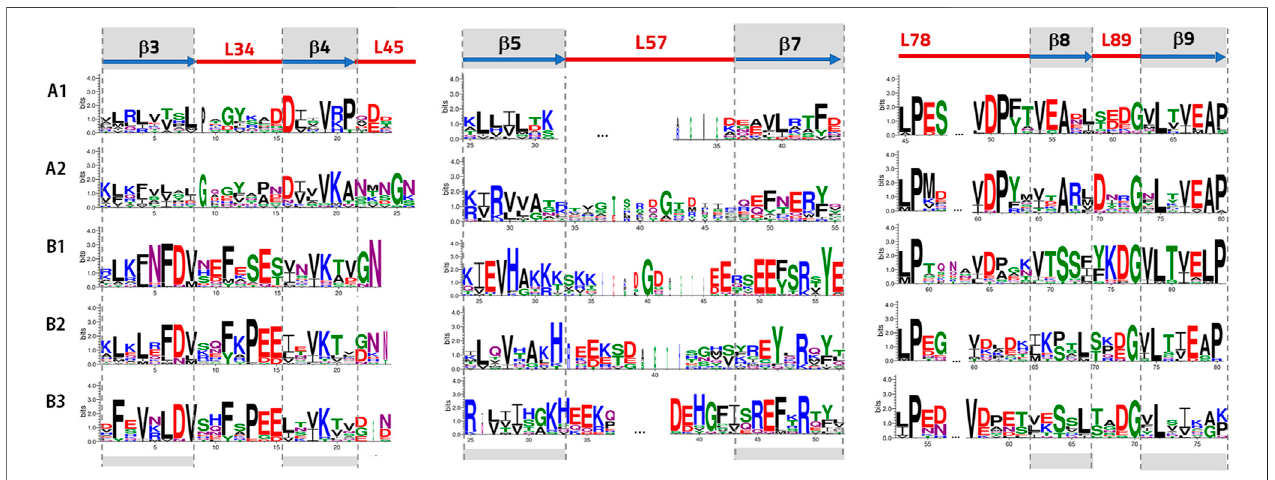
FIGURE 7 | Logo presentation using the WebLogo3 program (Crooks et al., 2004) for Clusters A and B. The height of each letter is proportional to its frequency. Amino acids are colored according to their chemical properties: acidic (D, E) in red, basic (K, R, H) in blue, polar (G, S, T, Y, C) in green, neutral (N, Q) in purple, and hydrophobic (A,V,L,I, p ,W,F,M) inblack.LogosforClustersB2andB3arecalculatedwithoutincludingthesequencesfromtheoutgroups( SupplementaryFileS2 , Supplementary Figure S17-S19 include logos for Clusters B2 and B3 calculated including the outgroups, but the differences are not signi fi cant.).